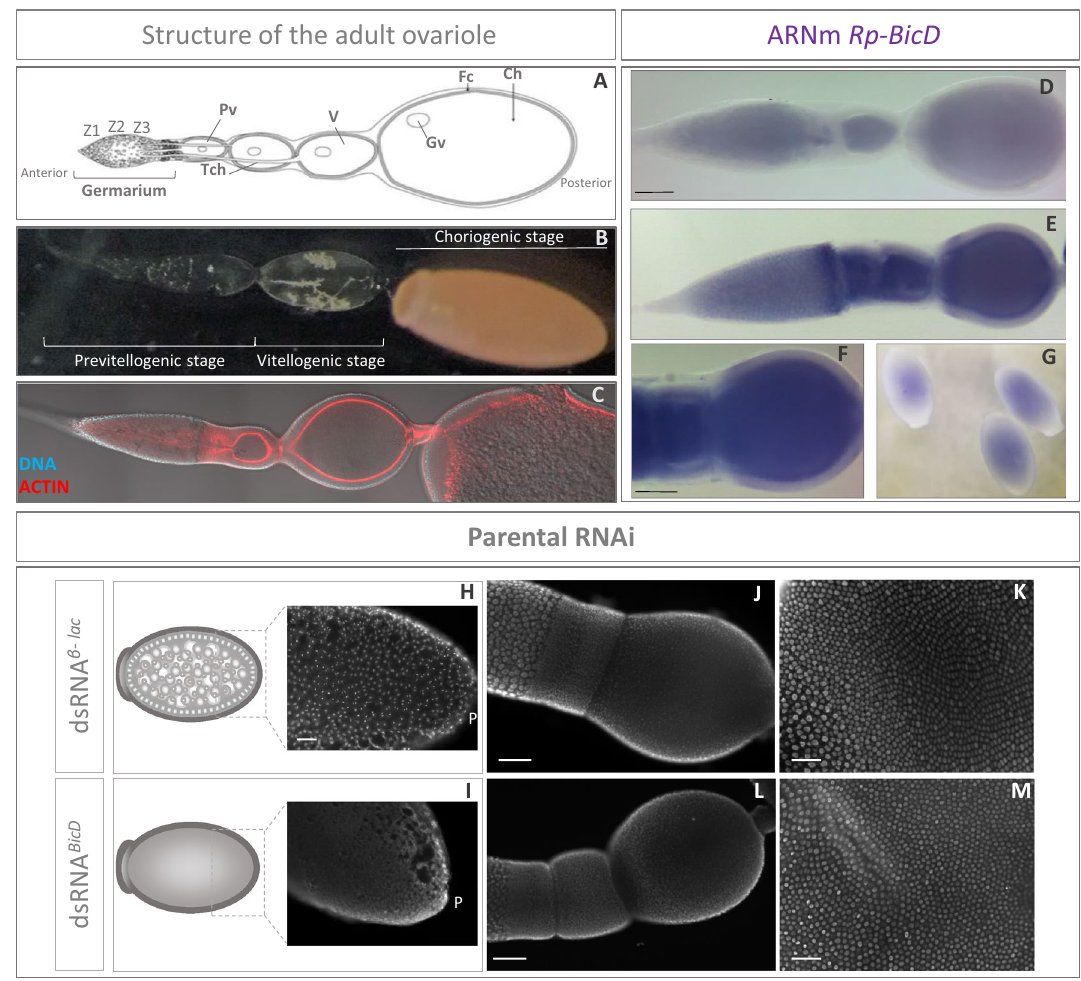
Figure 5. Silencing of Rp-BicD produces anembryonic eggs. ( A ) Schematic of the ovariole showing the germarium host mitotically active cells (i.e. nurse cells) in zone 1 (Z1), zone 2 (Z2) and zone 3 (Z3), and previtellogenic (Pv), vitellogenic (V) and choriogenic (Ch) oocytes. Each oocyte becomes encapsulated by follicle cells (Fc), and remains connected to the germarium through the trophic cords (Tch). Germinal vesicle (Gv). Schematic representation adapted from McLaughlin and Bratu 116 . ( B ) Structure of the ovariole showing the different stages that characterized oogenesis: previtellogenic, vitellogenic and choriogenic stage. ( C ) Ovariole of a control female showing the nuclei distribution by DAPI staining and the actin filaments by phalloidin staining 50,117 . ( D ) Detection of the sense probe by in situ hybridization assays in early stages of oogenesis. Scale Bar: 20 µm. ( E ) Detection of Rp-BicD transcript in the germarium and follicular cells of the ovariole with the antisense probe. Note the detection in Z3 of the germarium indicates Rp-BicD specific expression. Scale Bar: 20 µm. ( F ) Higher magnification of the developing oocytes. Notice the expression of Rp-BicD in the follicular cells. Scale Bar: 50 µm. ( G ) Detection of Rp-BicD transcript in unfertilized eggs by in situ hybridization. The arrowhead indicated the region of transcript accumulation. ( H ) Blastoderm embryo derived from control females. Note the nuclei distribution in the surface as revealed by DAPI staining. Scale bar: 100 µm. P: Posterior pole of the egg. ( I ) Egg from silenced (RNAi BicD ) females. Note the lack of nuclei in the surface of the embryo. Scale bar: 100 µm. P: Posterior pole of the egg. The developmental stages corresponding to both, control (G) and silenced (H), represent the cellular blastoderm (24 hPL ). ( J ) Ovariole of a control females showing the nuclei distribution by DAPI staining. Scale bar: 100 µm. ( K ) Follicular epithelium of vitellogenic oocytes from control females showing the nuclei distribution of the follicular epithelium by DAPI staining. Scale bar: 100 µm. ( L ) Ovariole of silenced (RNAi BicD ) females showing the nuclei distribution by DAPI staining. Scale bar: 100 µm. ( M ) Follicular epithelium in vitellogenic oocytes from silenced (RNAi BicD ) females showing the nuclei distribution of the follicular epithelium by DAPI staining. Scale bar: 100